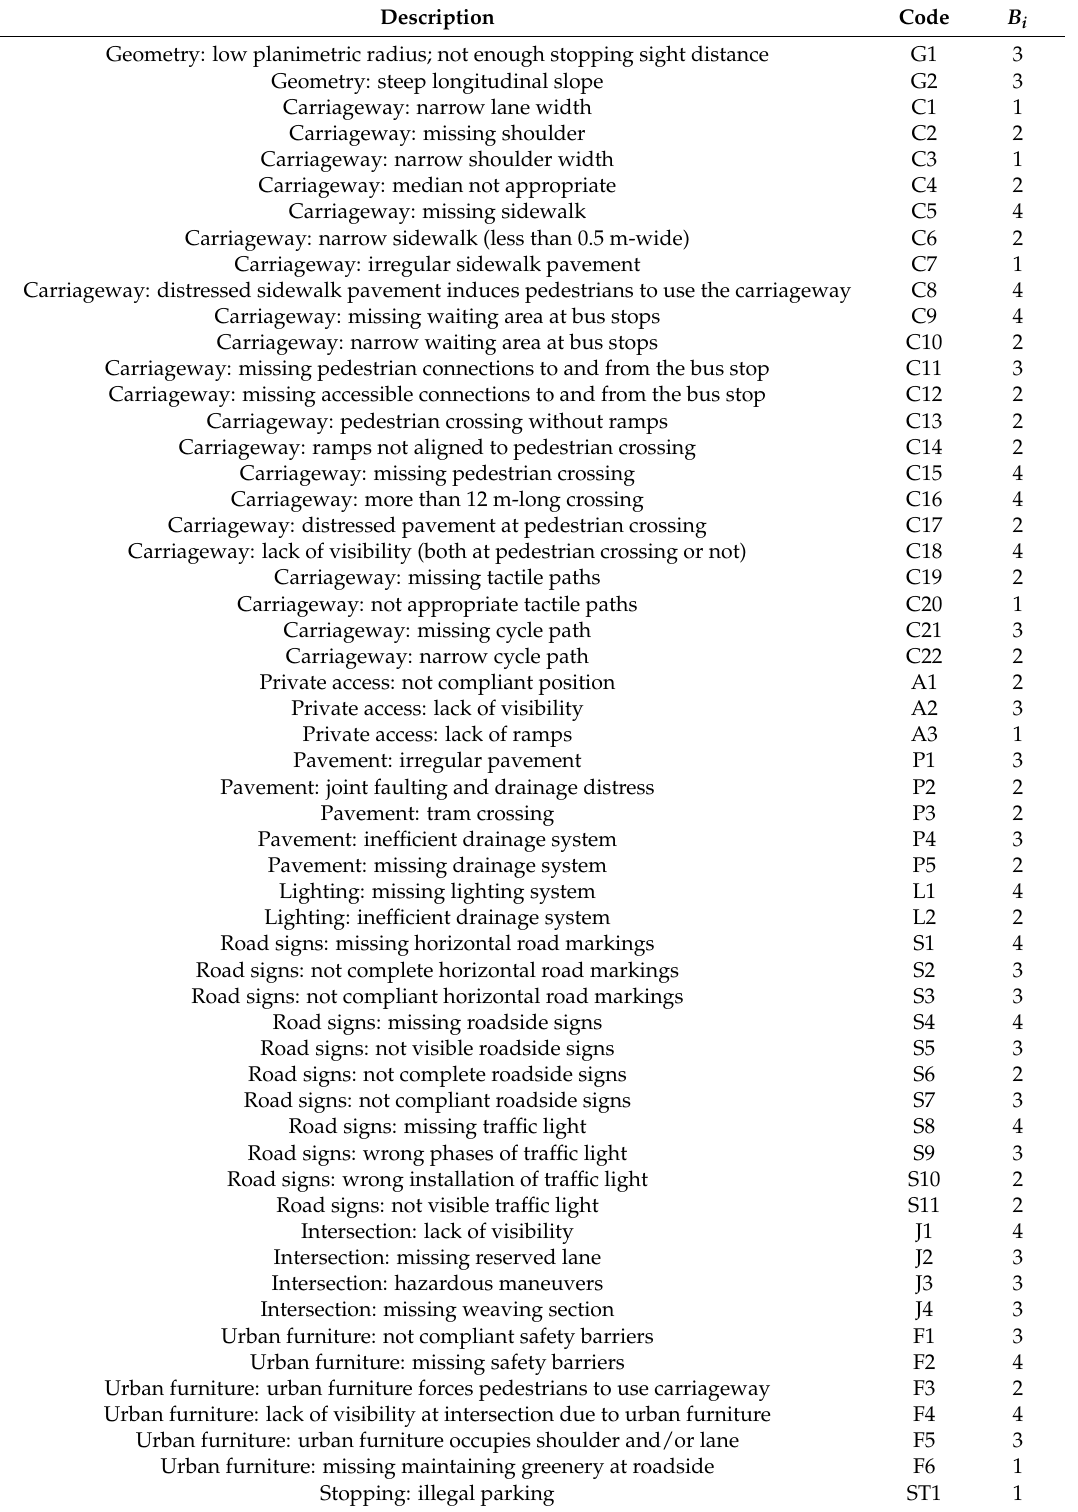
Table 2. Base values of